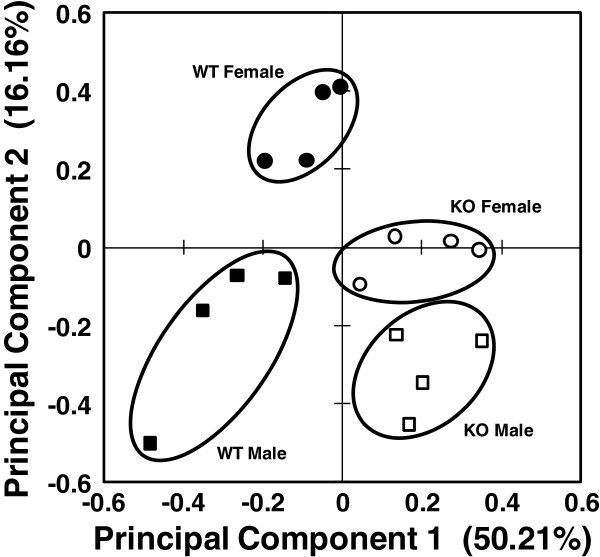
Principal component analysis of male and female baseline groups. A plot of the principal component analysis for the 218 significant (ANOVA, p < 0.05) protein spots differing between females and males is shown. The markers represent the weighted average for the first two principal components for the 218 proteins for each individual in each of the groups: Female WT (·), male WT (■), female KO (○), male KO (□).